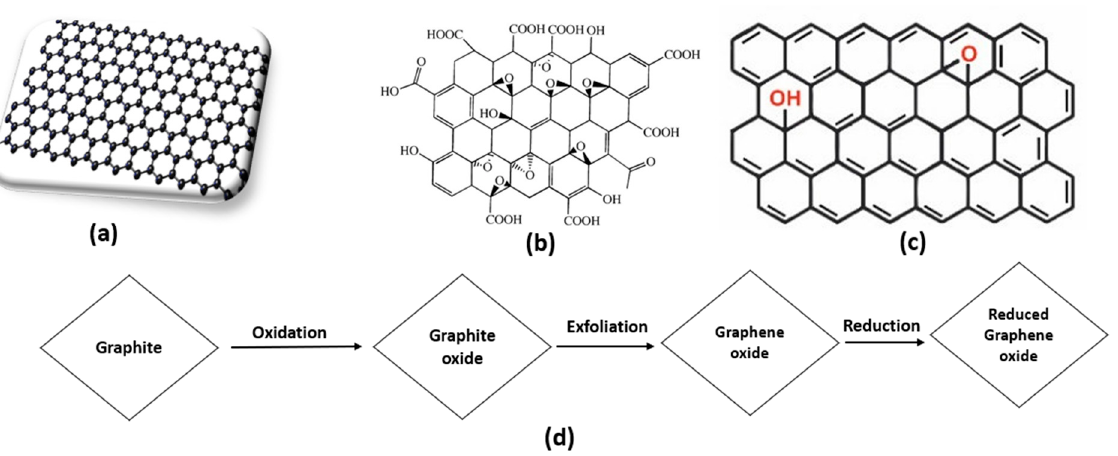
Figure 2. Structure of ( a ) graphene, ( b ) graphene oxide (GO), and ( c ) reduced GO (rGO), along with ( d ) the route of synthesizing rGO by reducing GO.